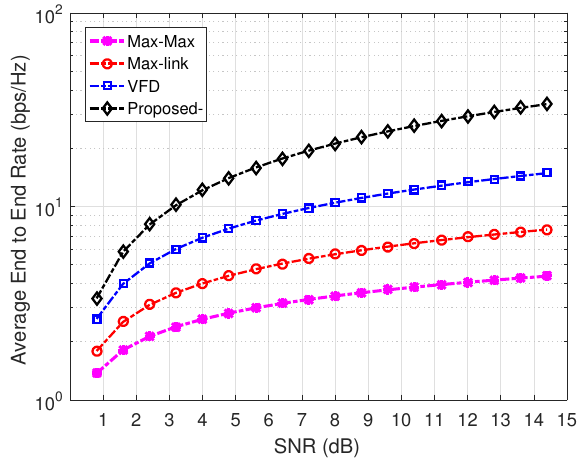
Figure 14. Average data rate vs.